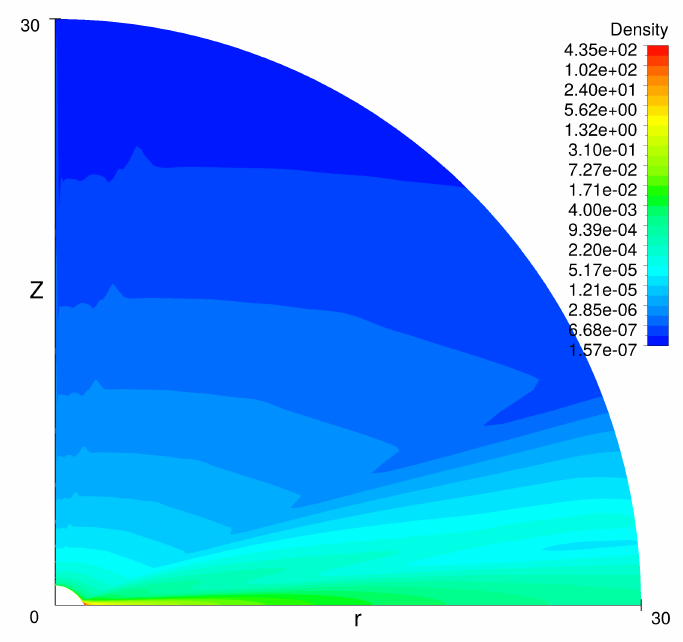
Figure 5. The density in the poloidal plane at ω =